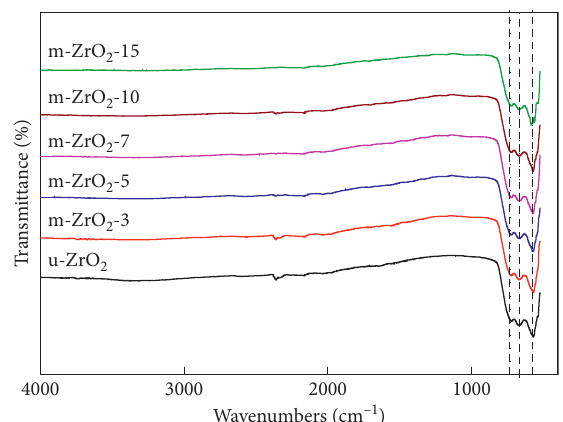
Figure 3: IR spectra of unmodified and modified ZrO